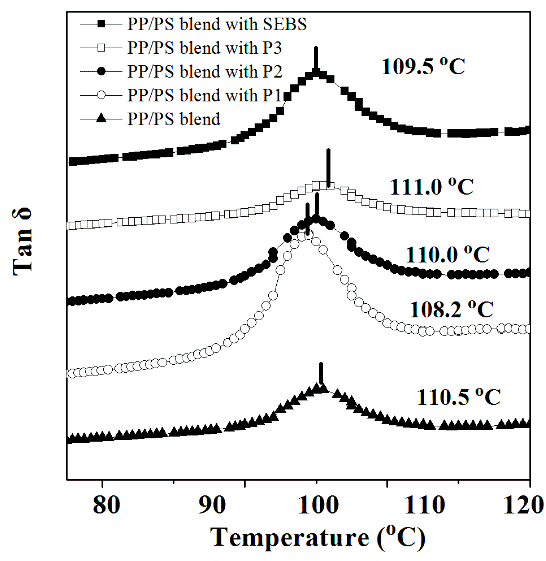
Figure 6. The T g of PS in the PP/PS blend and that of the blend with 2 wt% of compatibilizer.